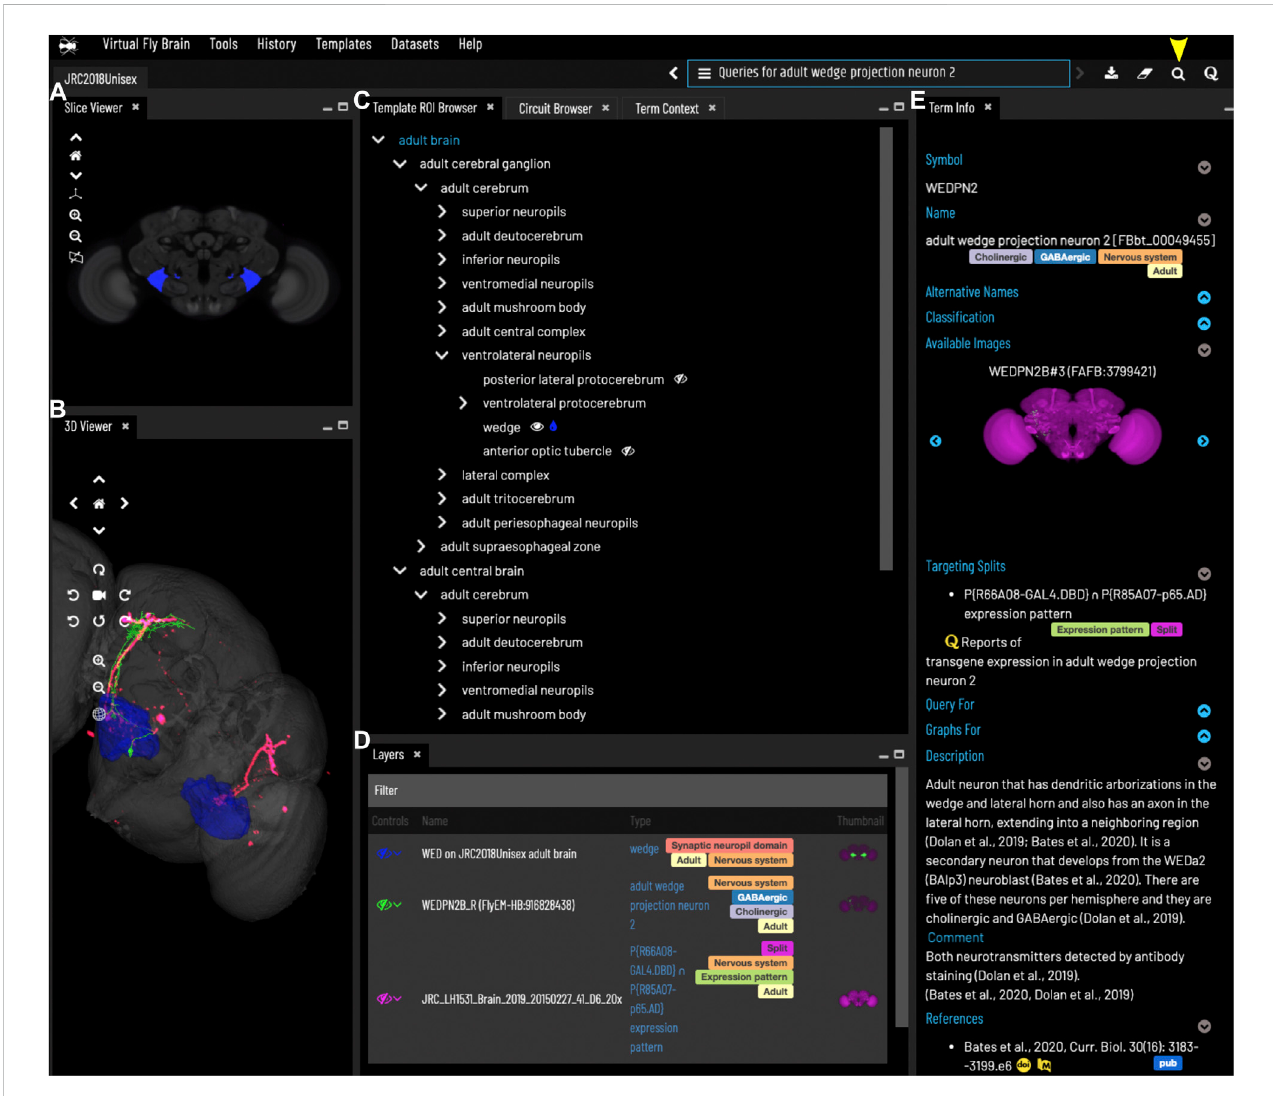
and allows these to be added to the display. (D) The Layers tool acts as a color key for all the entities currently loaded and features a set of controls allowing content to be removed, hidden or recolored. (E) The term info shows details of a selected entity, in this case a cell type. Available images of this cell type are shown as thumbnails and can be added to the viewer by clicking the thumbnail. Split-GAL4 lines that target this cell type are also shown in the Term Info. Cell types also have a description based on published information. Term Info for a different entity can be shown by clicking on something in the Term Info or Layers panes, searching or using the left/right arrows above the Term Info pane. Arrowhead at top right indicates the search